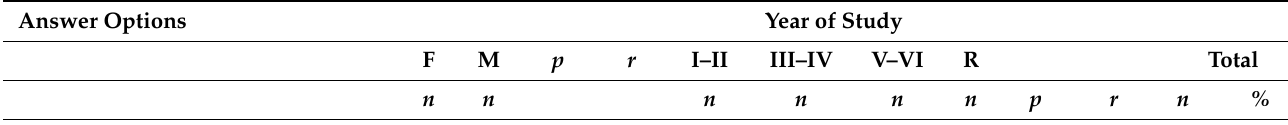
Table 6. Frequency distribution of answers to the questions about infection control of hand pieces and disinfection and sterilization by gender and year of